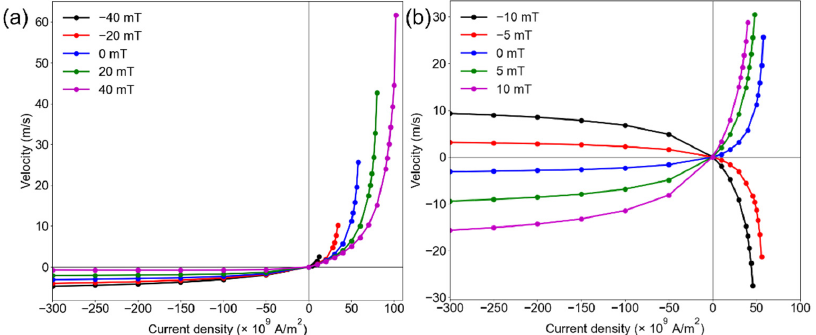
Figure 7. Velocity vs. current density for ( a ) a field applied along the y-axis orthogonal to the wire and ( b ) applied parallel to the wire. All data are shown for an initial M y = − 1 Bloch chirality.